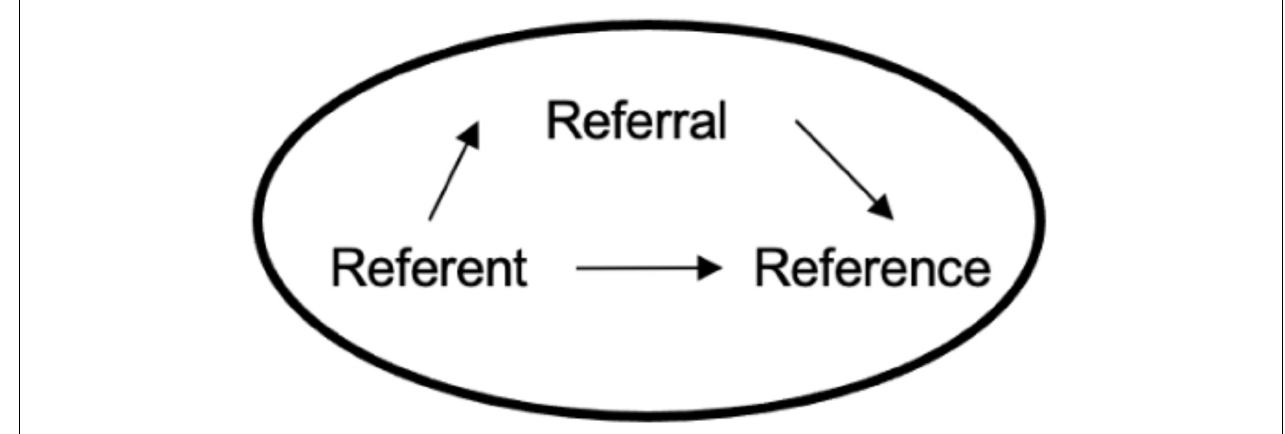
FIGURE 1 | Structure of the components of any